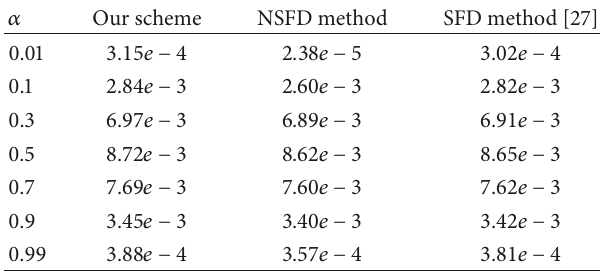
Table 6: Error norm 𝐿 ∞ for Example 7.